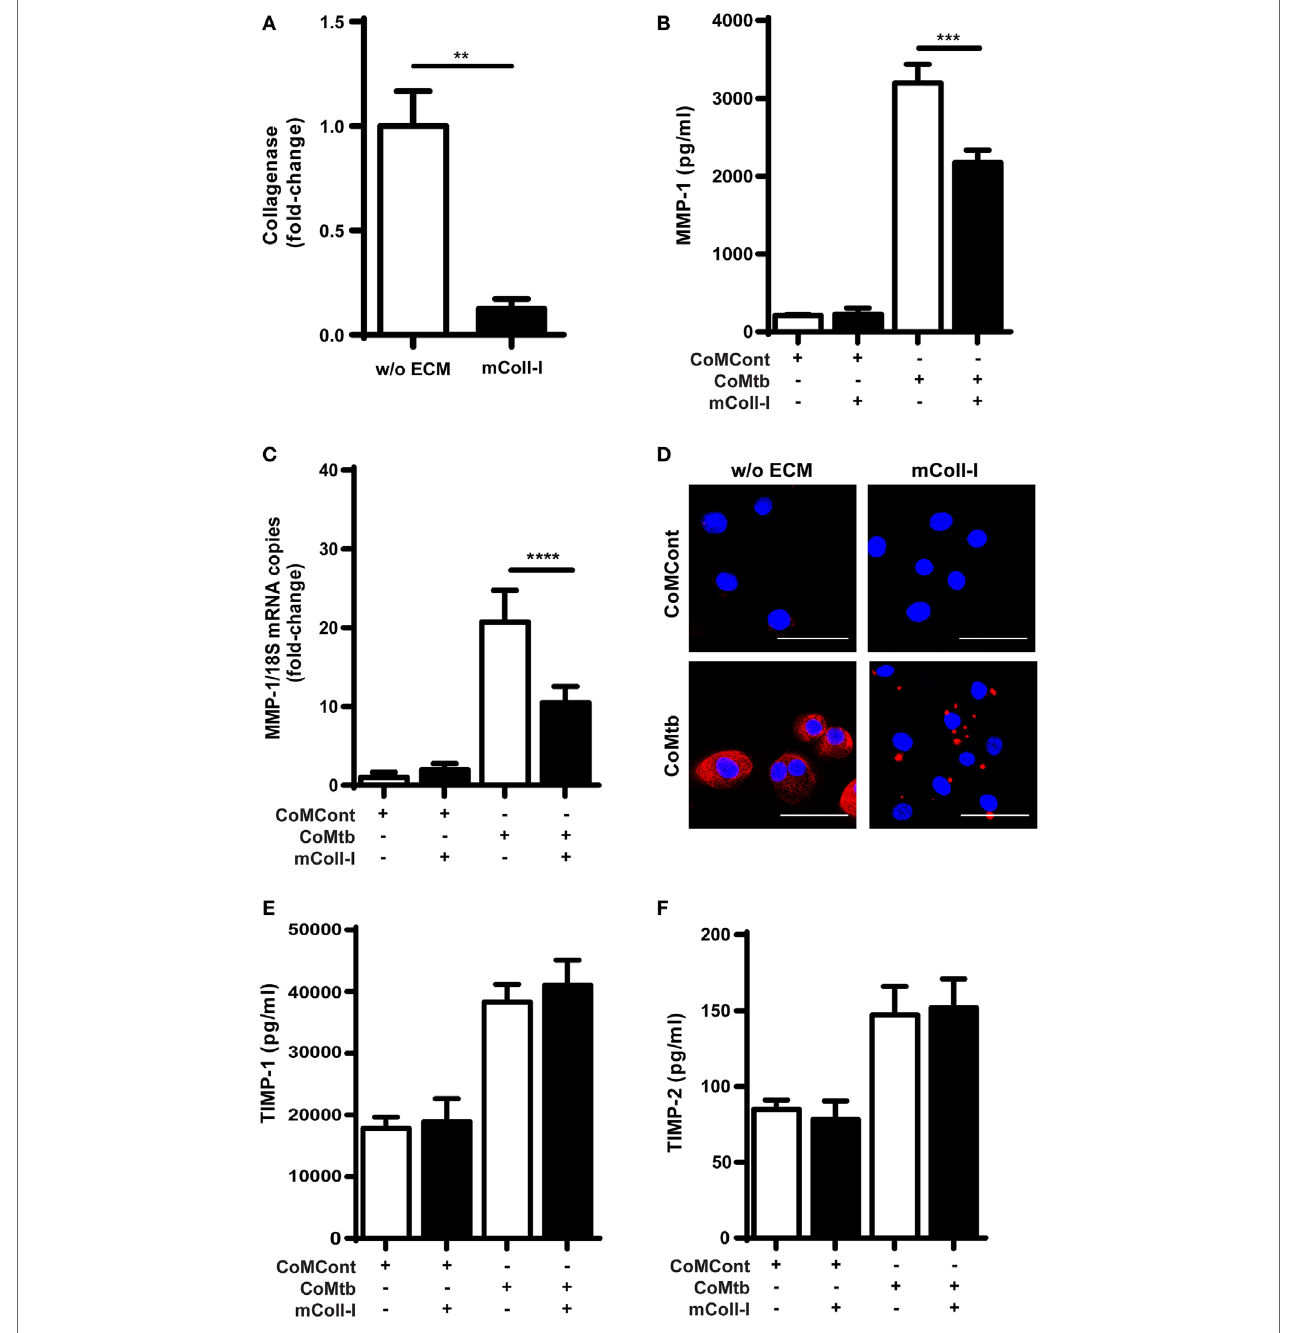
FigUre 1 | Collagen matrix regulates collagenase activity and matrix metalloproteinase (MMP)-1 expression in CoMtb-stimulated human bronchial epithelial cells (HBECs). HBECs were cultured in the presence of matrix type I collagen (mColl-I) or without extracellular matrix (ECM) and stimulated with CoMtb or control medium (CoMCont). Supernatants were collected at 24 h for analysis of collagenolytic activity and protein secretion, while cell lysates were collected at 6 h for total RNA extraction and analysis of MMP-1 gene expression. (a) Fold-change in collagenase activity. Basal collagenase activity in control HBECs was subtracted from respective CoMtb-stimulated wells. Fold-change is relative to mean collagenolytic activity from cells in the absence of ECM. (B) MMP-1 secretion (pg/ml). (c) Fold-change in MMP-1 mRNA accumulation, normalized to 18S mRNA as reference control. Fold-change is relative to mean MMP-1 expression in control wells without ECM. (D) Confocal microscopy images from control (CoMCont) and CoMtb-stimulated HBECs cultured in the presence or absence of matrix Coll-I ( n = 2). Slides were stained with DAPI (blue) for nucleic acids and anti-MMP-1 primary antibody and Cy5 conjugated anti-rabbit secondary antibody (red). Scale bar: 50 µm. (e) Tissue inhibitors of metalloproteinases (TIMP)-1 and (F) TIMP-2 secretion. Plots show mean and SD of assays performed in triplicate, which were replicated on three occasions. p -Values were obtained with one-way ANOVA with Tukey’s range test. ** p < 0.01; *** p < 0.001; **** p < 0.0001.